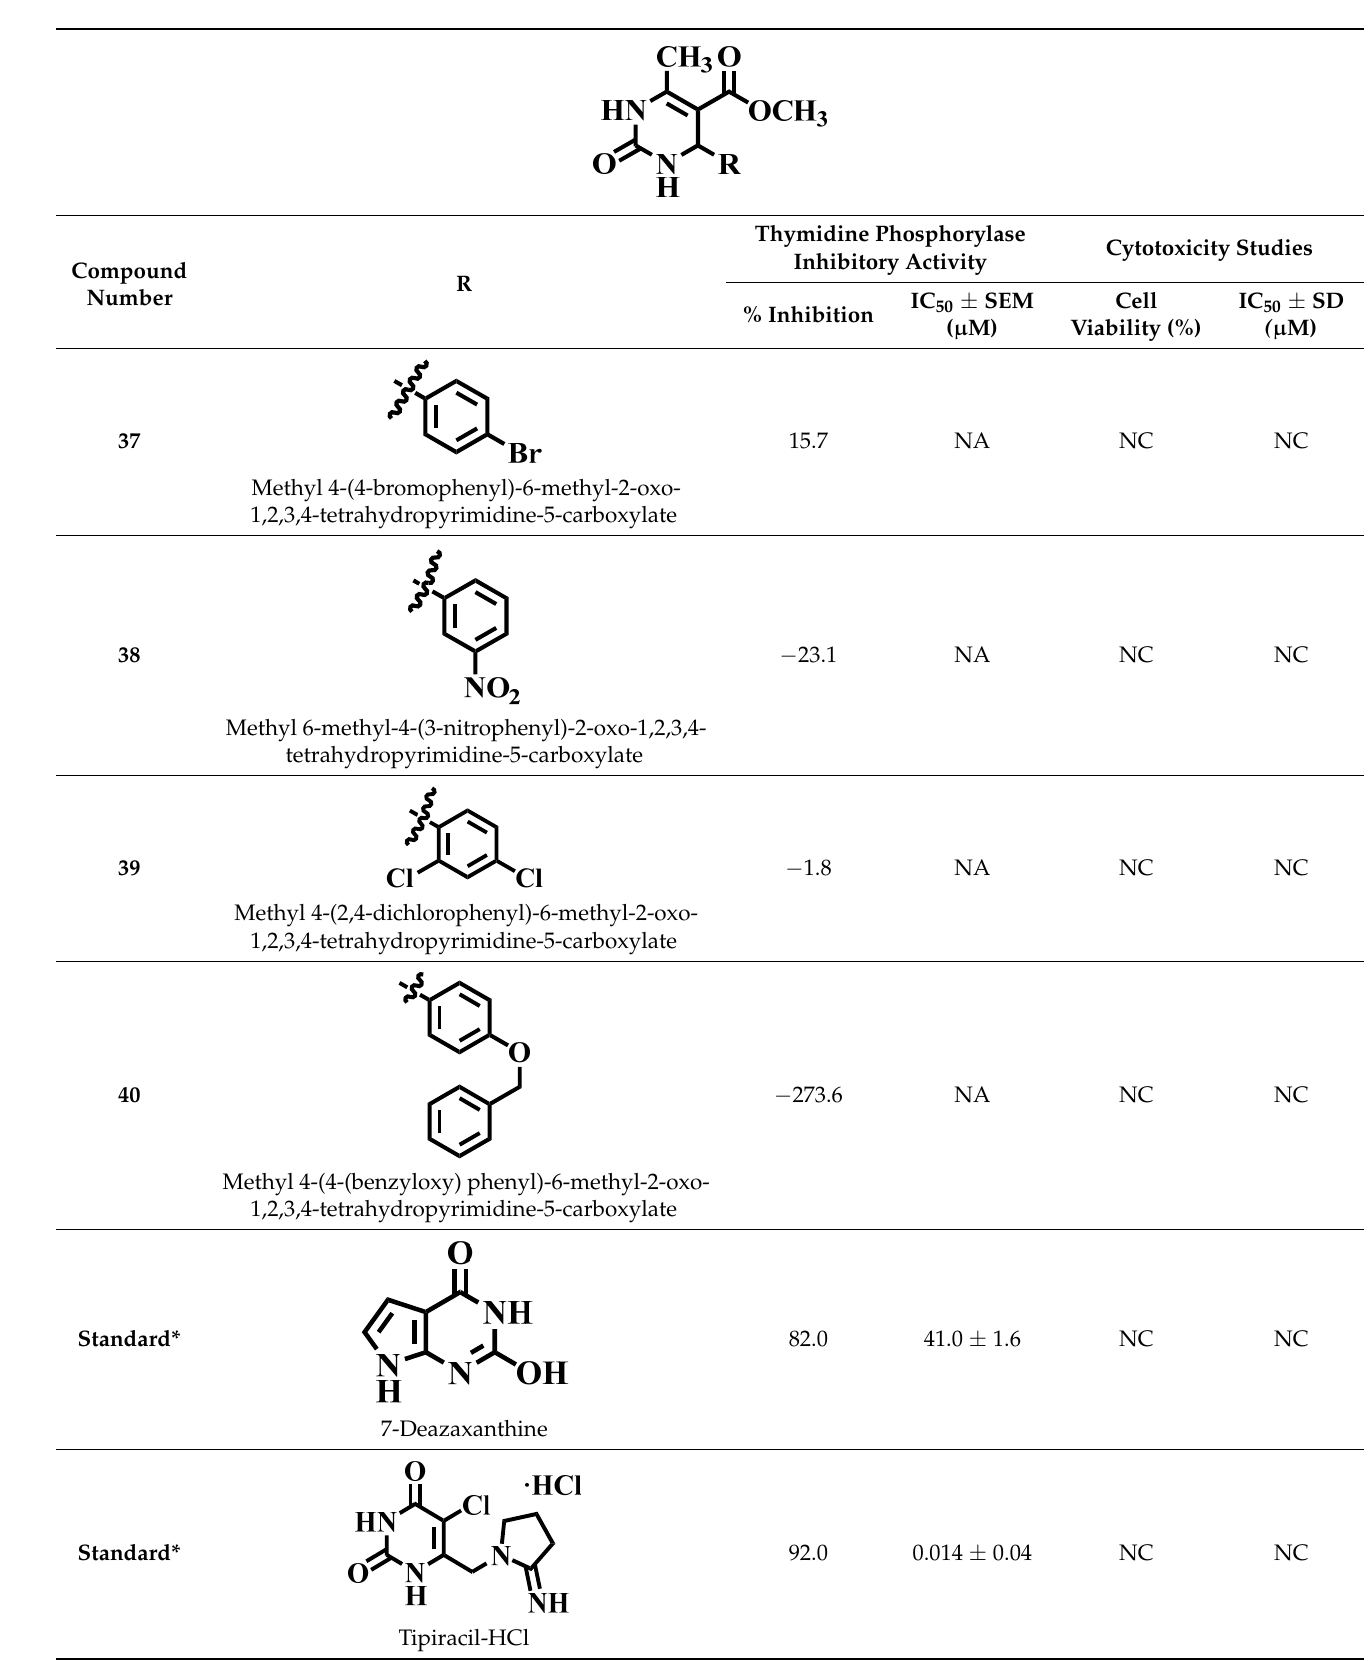
Table 1. Thymidine phosphorylase (TP) inhibitory activity of dihydropyrimidone ( 1 – 40 Table 1. Cont.